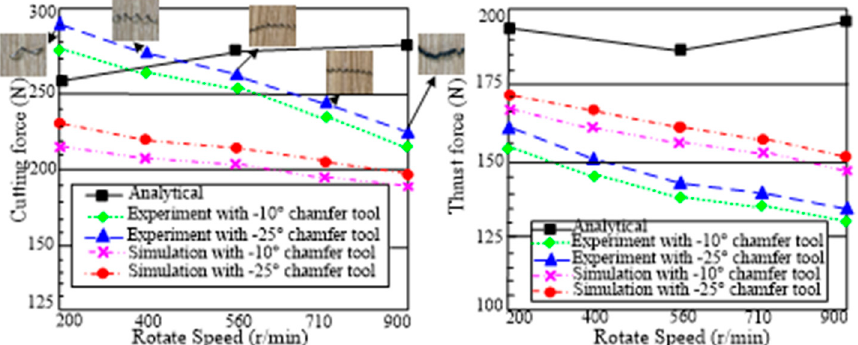
Figure 10. Effect of rotating speed on the cutting and thrust force. Numerical predictions are com- pared with experimental results and analytical results of Ren [25]. compared with experimental results and analytical results of Ren